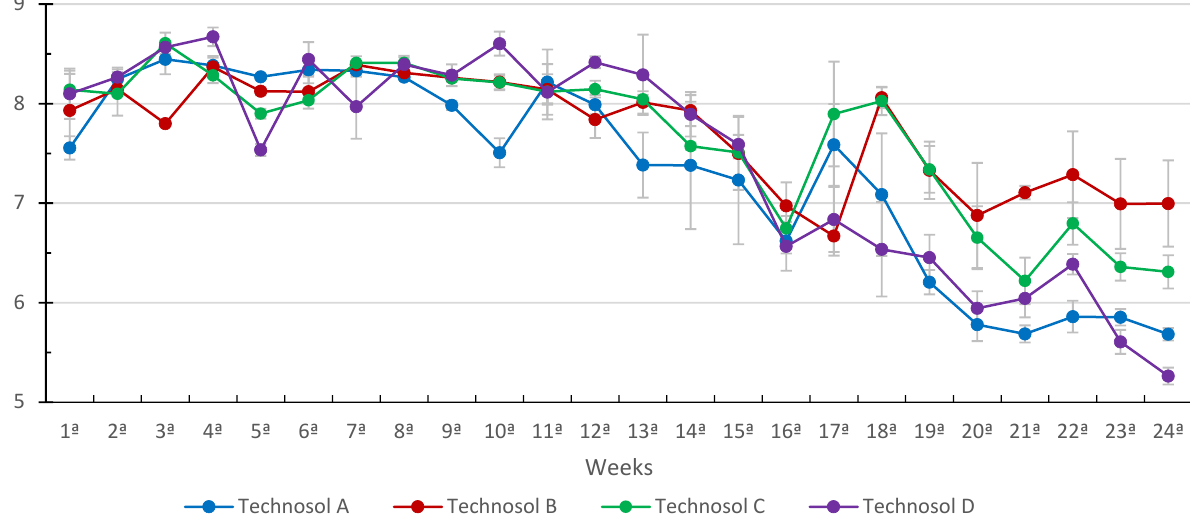
Figure 4. pH changes in leachates along the 24-week experiment indicating that the buffering capacity of carbonates decreases with time. Values indicated by same letters in columns do not differ according to the Tukey test ( p <